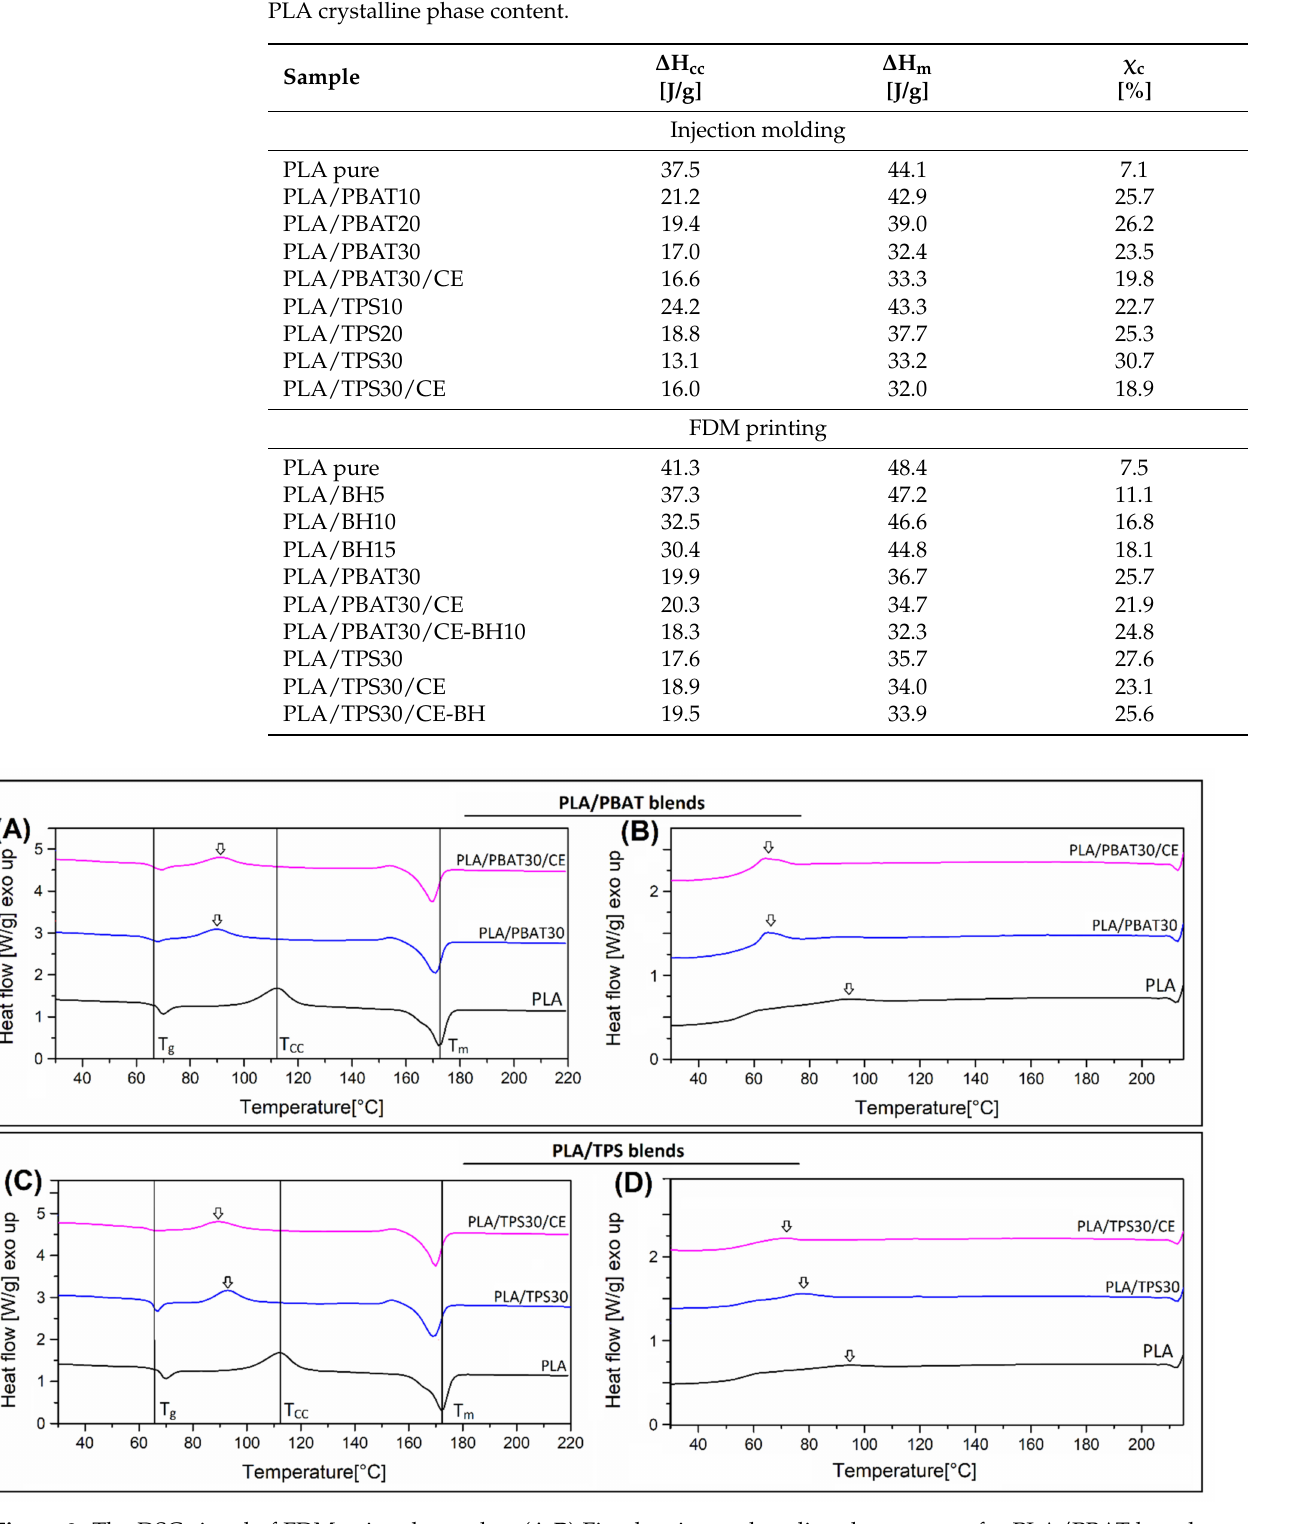
Figure 8. The DSC signal of FDM-printed samples. ( A , B ) First heating and cooling thermogram for PLA/PBAT-based materials. ( C , D ) First heating and cooling thermograms for PLA/TPS